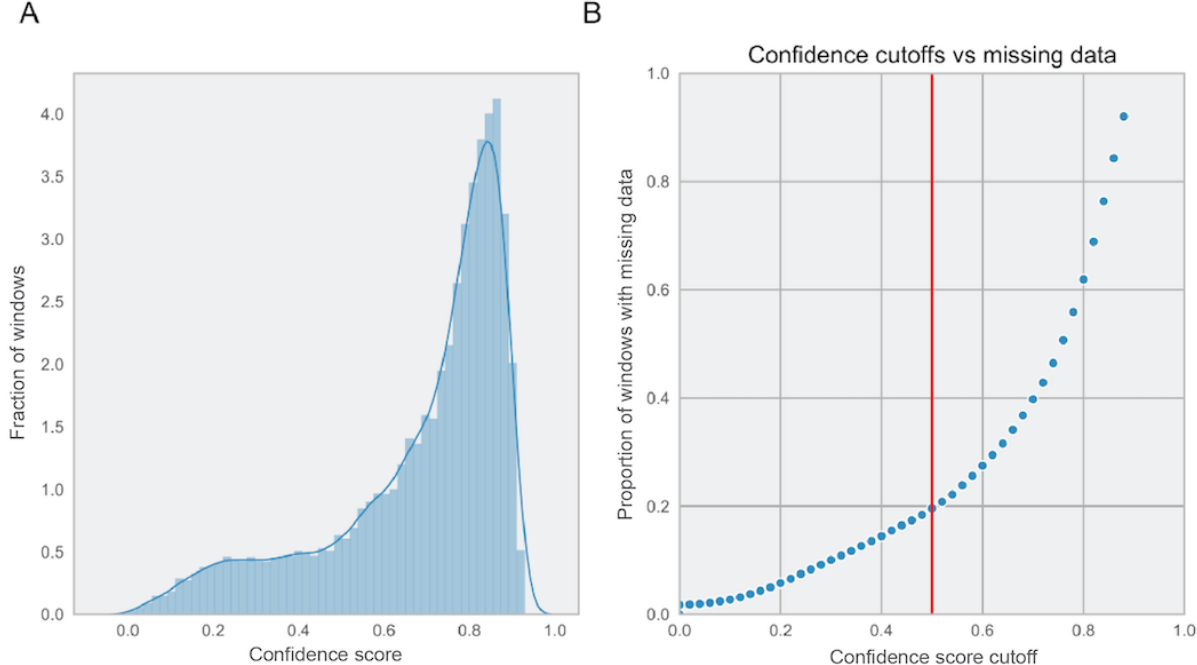
Figure 4. Effect of different confidence cutoff on the amount of missing data from the calibration study. (A) Distribution of best confidence across red and green channels in the calibrations study and (B) percent of the 10 second windows that are filtered out at different cutoffs of the confidence score. The cutoff used in the analysis is 0.5 marked by the red line.